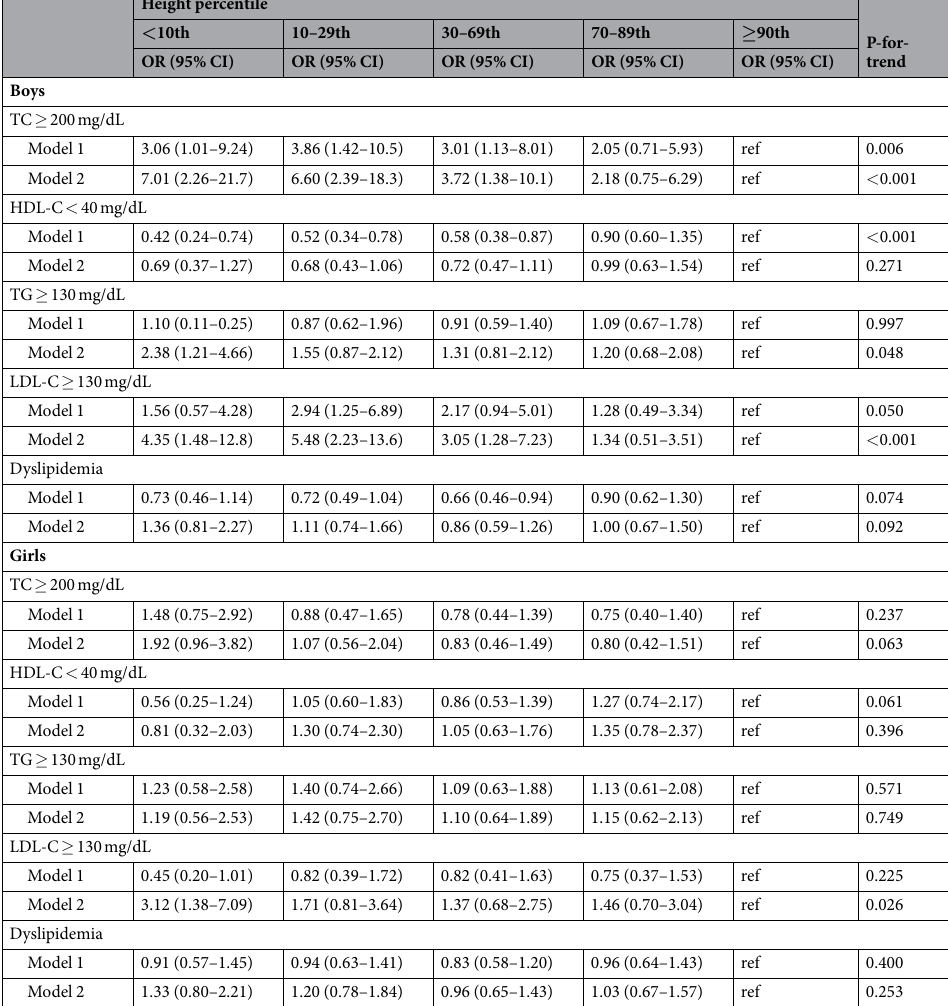
Table 3. Adjusted odds ratios (95% confidence interval) for dyslipidemia in adolescents according to the height percentile. Model 1: Unadjusted. Model 2: Adjusted for age, waist circumference, systolic/diastolic blood pressure, fasting glucose levels, household income, physical activity, and alcohol consumption. CI, confidence interval; HDL-C, high density lipoprotein-cholesterol; LDL-C, low density lipoprotein-cholesterol; OR, odd ratio; TC, total cholesterol; TG,